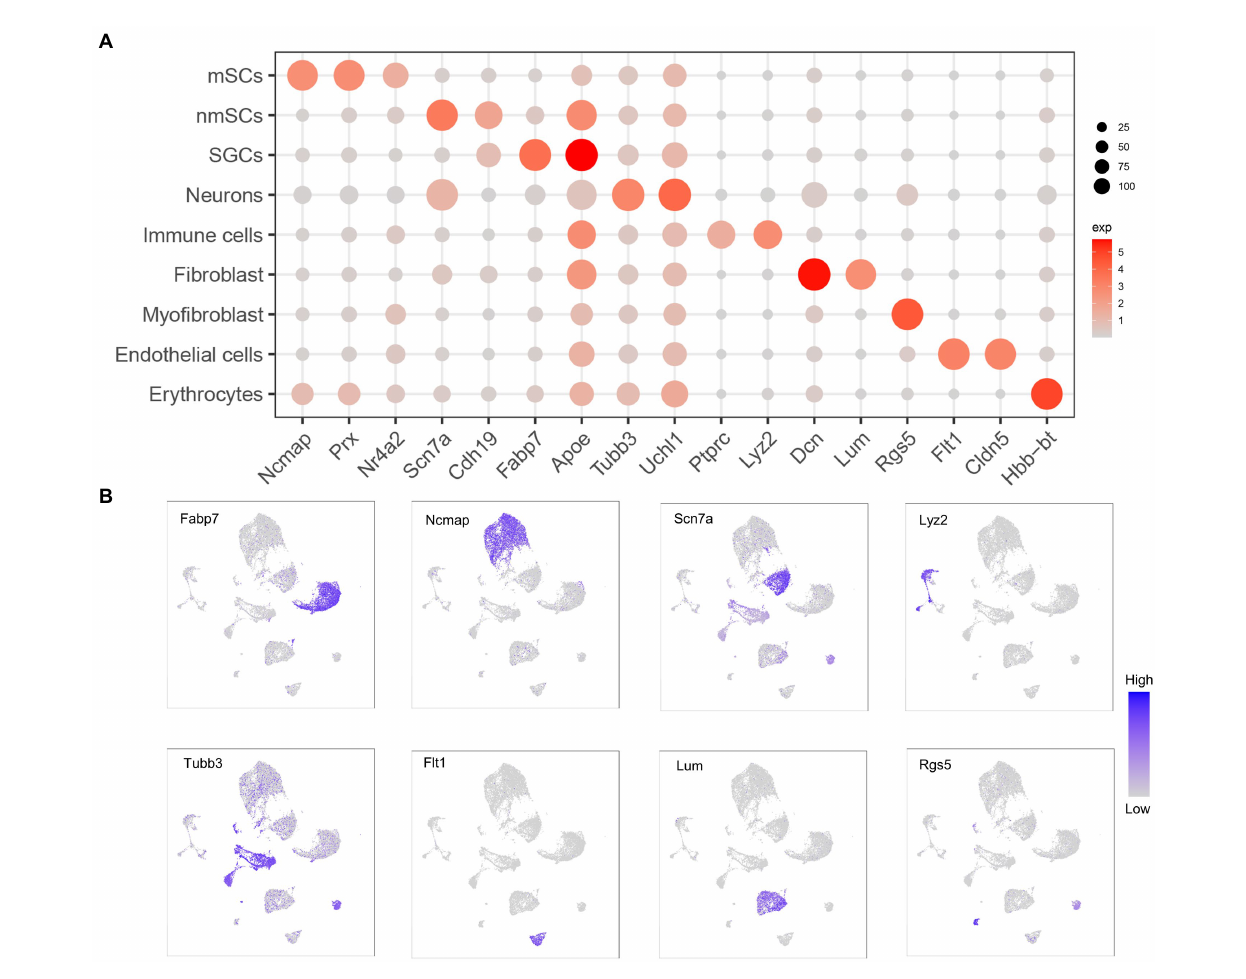
FIGURE 2 Expression of marker genes in different cell clusters of TG. (A) Dot plot showing expression of marker genes selected from TG data for identification of cluster cell types. Dot size is proportional to the percentage of each cluster expressing the marker gene, and the color intensity is correlated with the expression level. (B) The UMAP expression plots of marker genes for TG cell